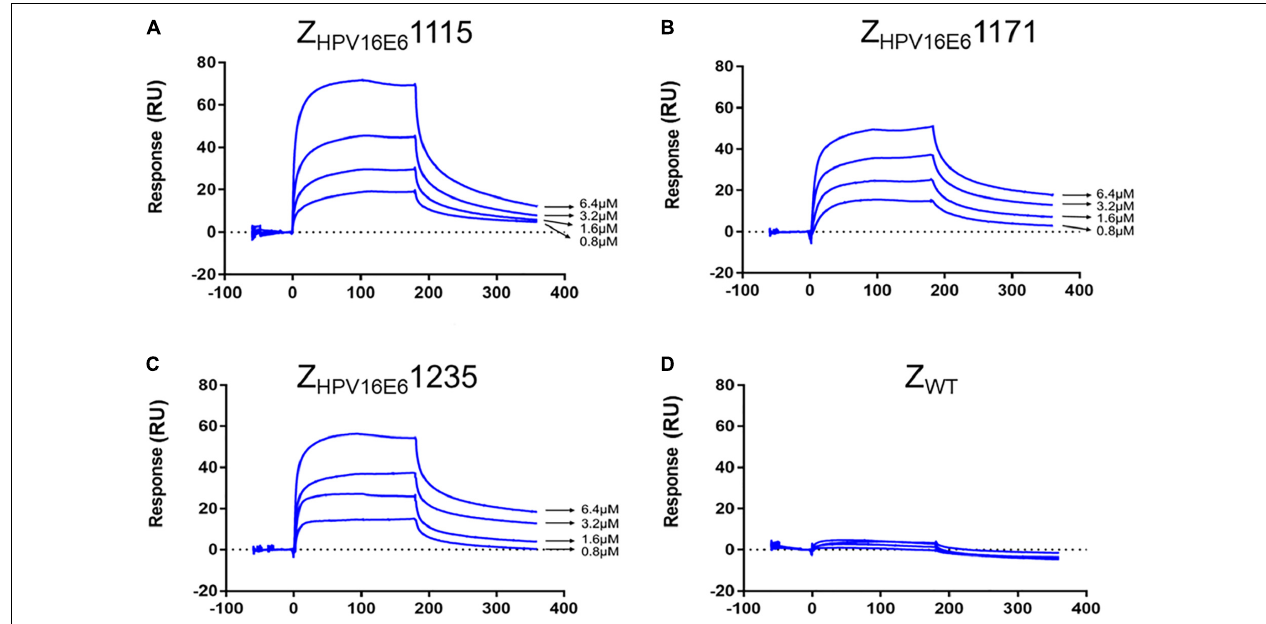
FIGURE 2 | SPR analysis of the interaction between Z HPV16E6 affibodies and the immobilized HPV16 E6 target ligand. Sensorgram obtained after injection of different concentrations of purified Z HPV16E6 1115 (A) Z HPV16E6 1171 (B) and Z HPV16E6 1235 (C) over the surface with immobilized recombinant HPV16 E6. Z WT affibody was set as a control (D) .